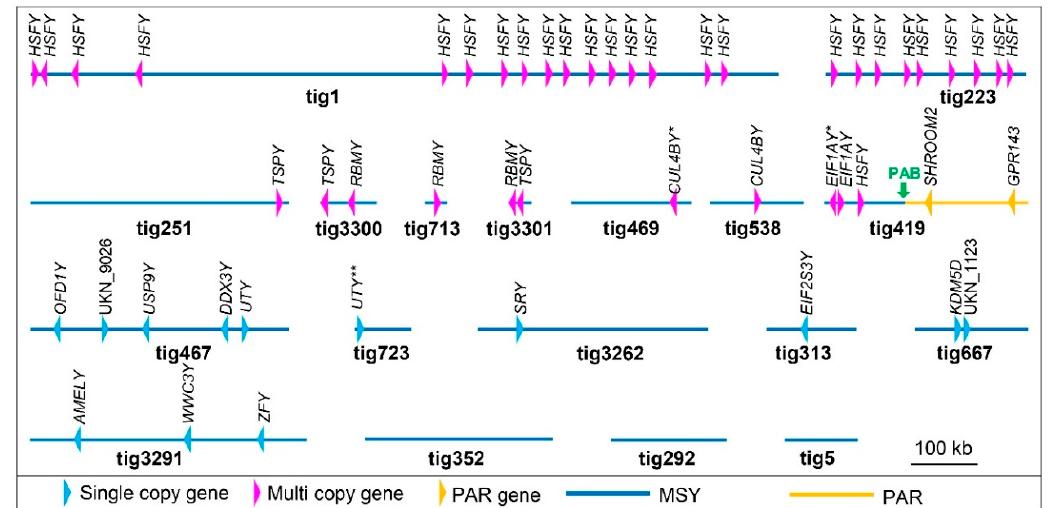
Figure 3. Alpaca Y contigs and mapped genes. Schematic drawings of 18 MSY contigs showing the relative position and orientation (arrowheads) of annotated genes and transcripts. The length of contigs and the position of genes are drawn to the scale; PAB—pseudoautosomal boundary; *—truncated copies of EIF1AY and CUL4BY ; **—single copy UTY is split between two contigs.